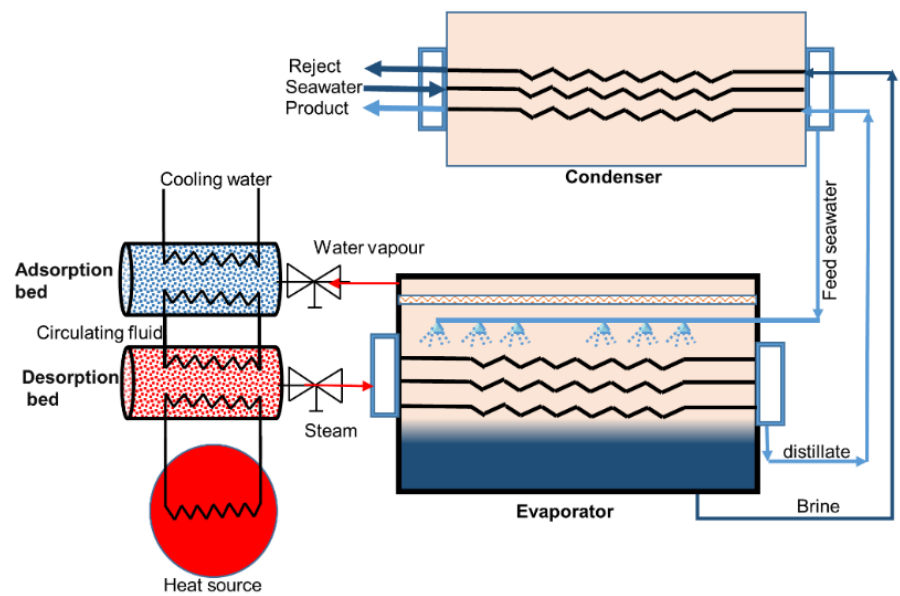
Figure 10. Single-stage evaporation with adsorption/desorption beds as heat pump.